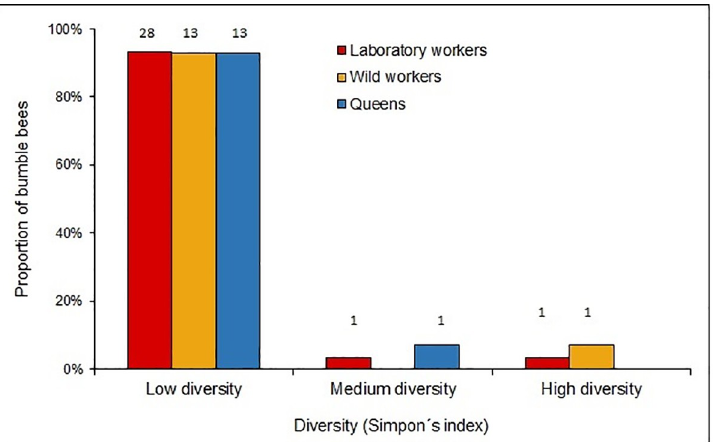
Fig 1. Diversity of phoretic mites in bumble bees B . pauloensis . Proportion of bumble bees with low (0–0.3), moderate (0.3–0.6) and high (0.6–1) diversity of phoretic mites based on Simpson’s index values. Numbers above columns indicate sample